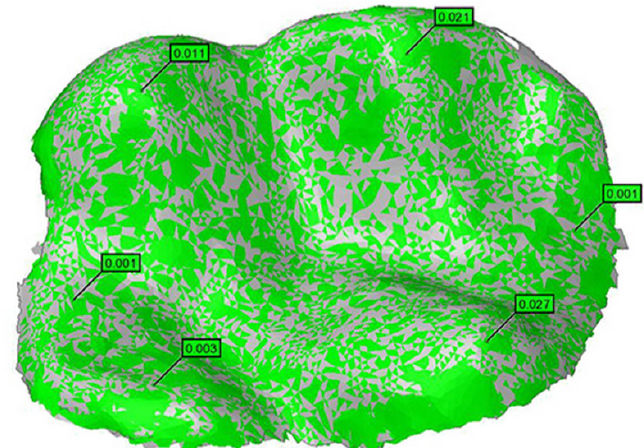
Figure 1. Six points showing differences (mm) between pre-cementation and post-cementation superimposed on standard tessellation language (STL) files showing 6 measurement points.